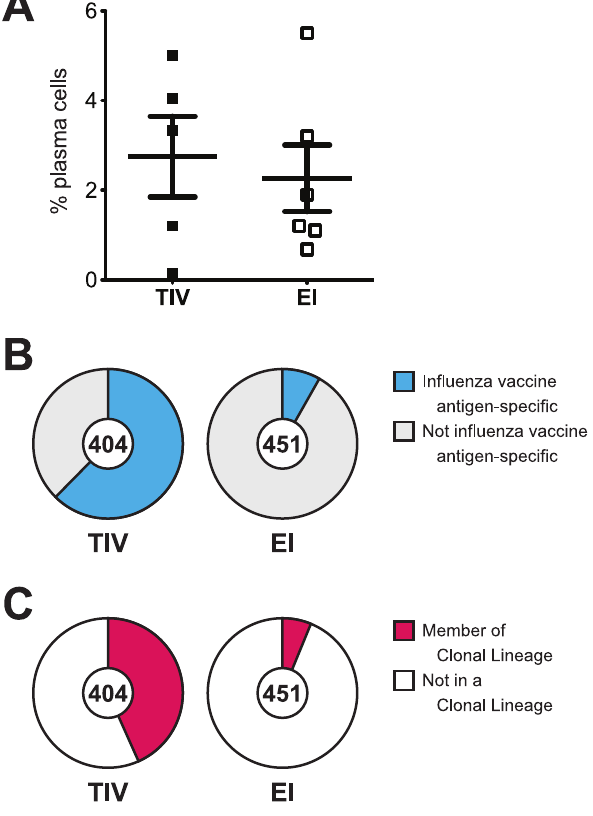
Figure 1. Characterization of peripheral blood plasmacytosis 7 days after TIV or EI. A. Peripheral blood B cells (CD3/14/16/235a 2 CD19 + ) stained for plasma cell markers (CD3/14/16/235a 2 CD19 + CD20 2 /lo CD27 hi CD38 hi ); points shown are percentage of B cells that were plasma cells. TIV mean 2.75% 6 0.90%; EI mean 2.26 6 0.74%; two- tailed t test, p =0.68. B. Human rmAbs derived from sorted plasma cells tested for reactivity. From TIV subjects, 252/404 rmAbs (62.4%) reacted with $ 1 influenza antigen (blue wedge), 152/404 (37.6%) did not react with any tested rHA or split-virus antigen (gray wedge). From EI subjects, 37/451 rmAbs (8.2%) reacted with $ 1 influenza antigen (tested vs. TIV, x 2 =279.5, p , 0.0001), 414/451 (91.8%) did not react with any tested rHA or split-virus antigen. C. Human rmAbs membership in clonal lineages. From TIV subjects, 175/404 (43.3%) rmAbs were members of 46 clonal lineages (red wedge); from EI subjects, 28/451 (6.2%) rmAbs were members of 12 clonal lineages ( x 2 =162.1, p ,